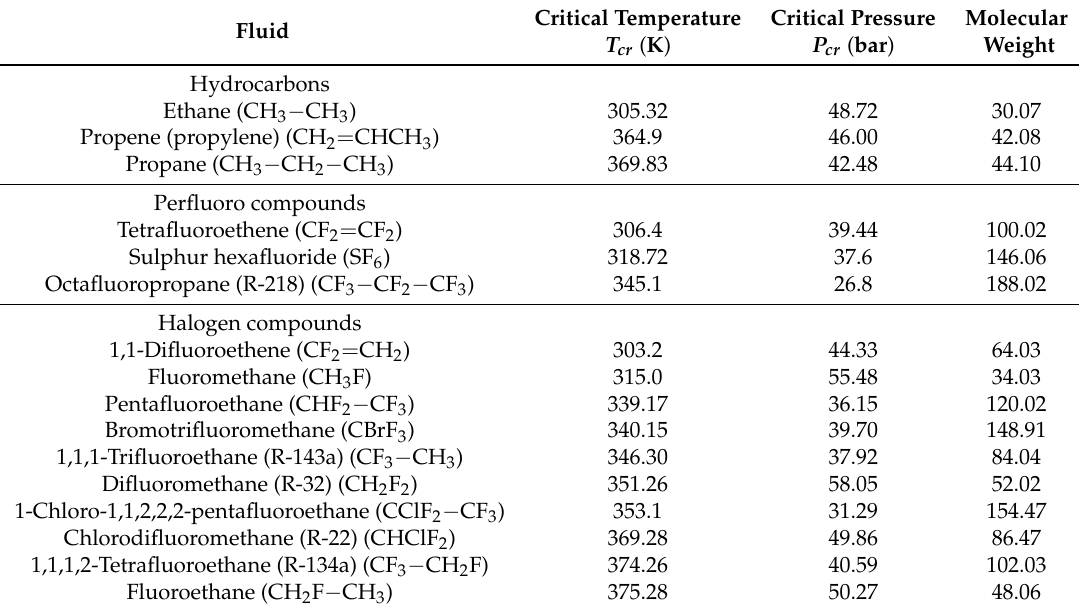
Table 2. Some potential working fluid compounds in closed real-gas Brayton cycles. Data are from [15] (Appendix A).